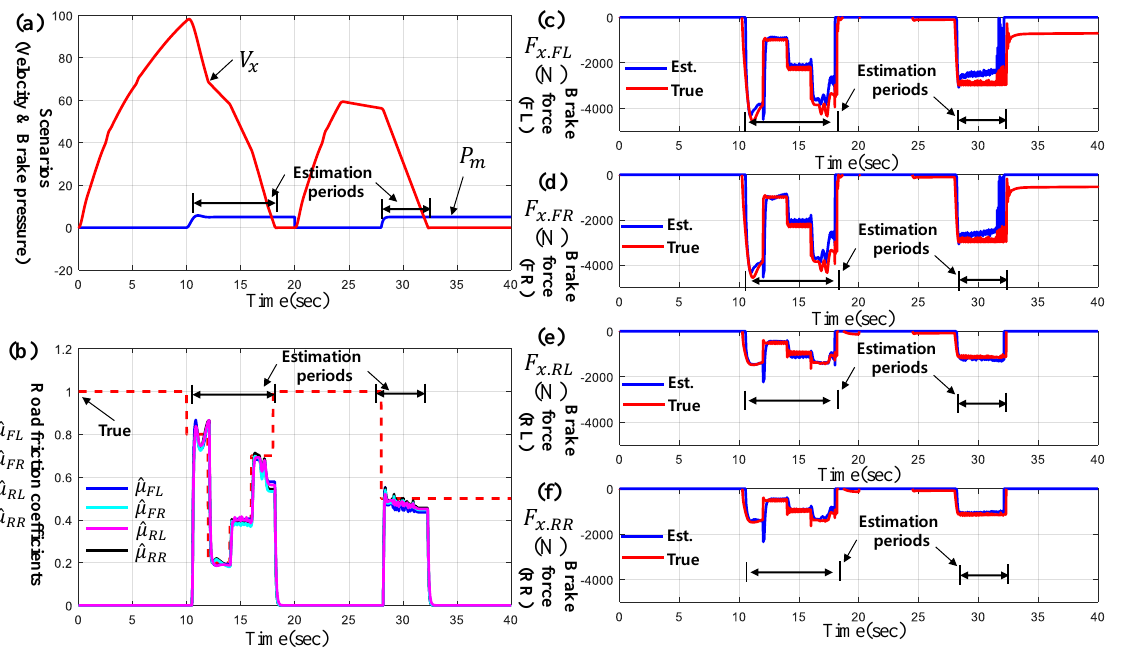
Figure 14. Estimation results of road friction coefficients and brake forces with m v = 2100 kg. ( a ) Vehicle speed and brake scenarios, ( b ) estimates of road friction coefficients, ( c ) brake force of FL wheel, ( d ) brake force of FR wheel, ( e ) brake force of RL wheel, and ( f ) brake force of RR wheel. Table 2. Correlation coefficient for data comparison of brake forces for Figures 13 and 14. Front Axle Rear Axle Left: 92.93% match Left: 90.08% match First brake ( Figure 13 ) Right: 93.5% match Right: 92.02% match Left: 89.85% match Left: 87.95% match Second brake ( Figure 14 ) Right: 88.60% match Right: 87.09% match